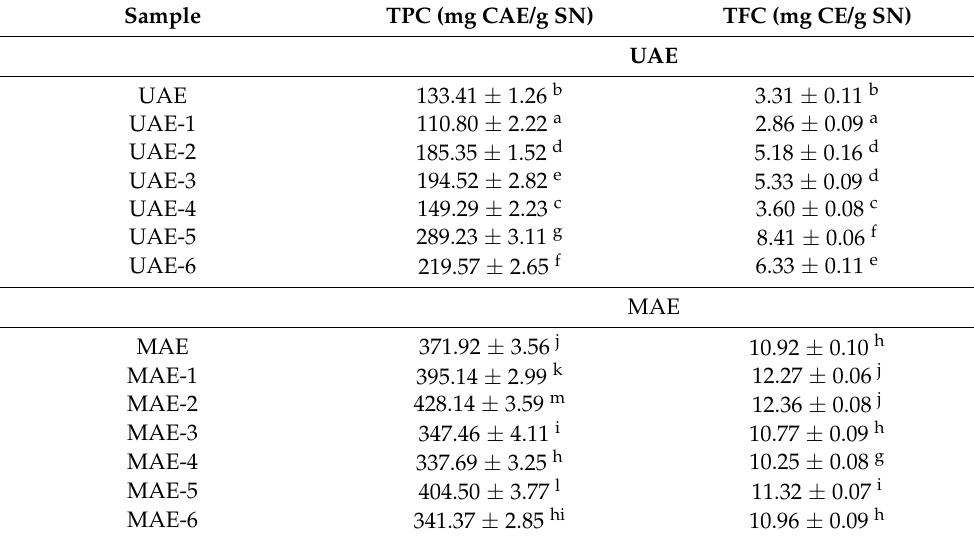
Table 3. Total phenolic and flavonoid